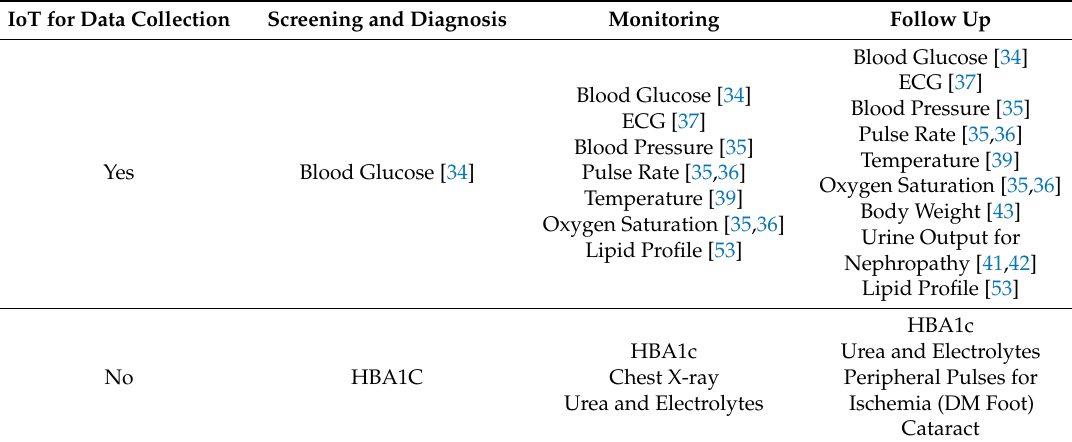
Table 5. Required data and IoT availability of diabetes